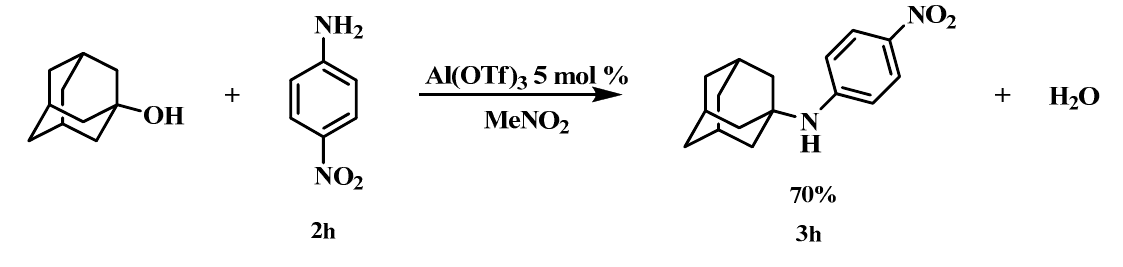
Figure 4. Adamantylation of primary amides and ethyl carbamate.